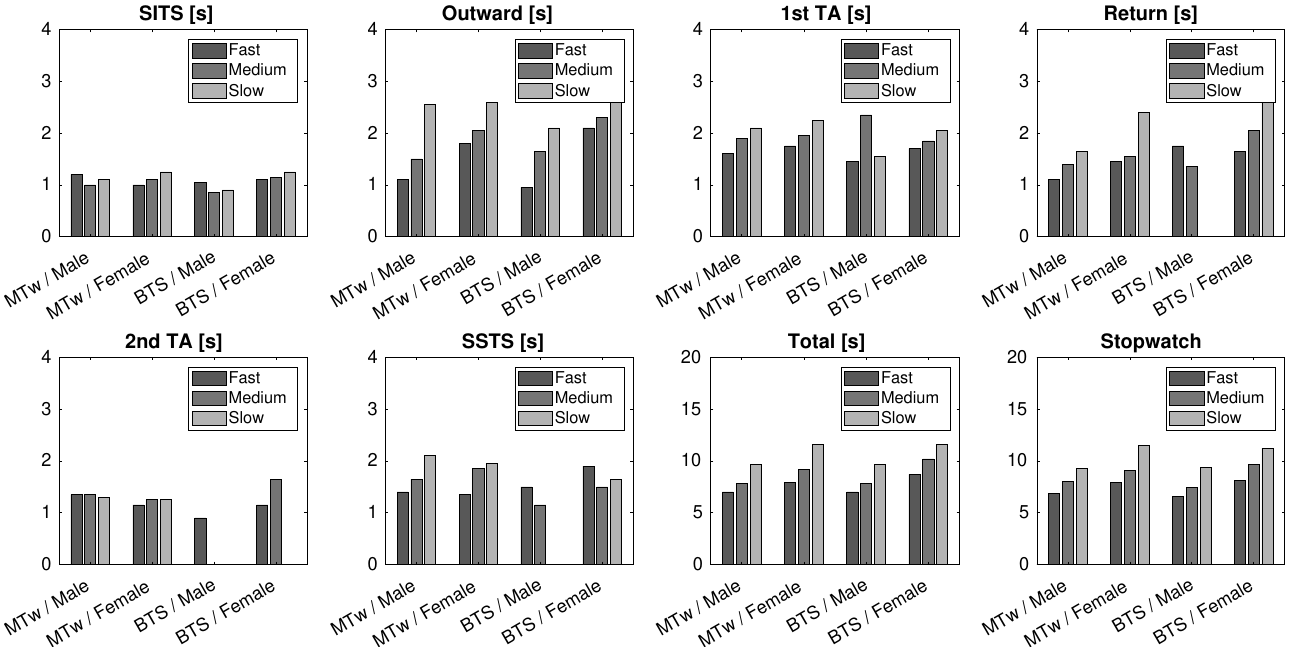
Figure 14. Phase times obtained by the TUG Test, for the two tested sensors (MTw and BTS). All data are in seconds.